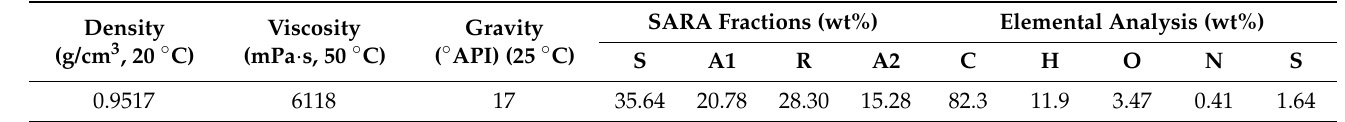
Table 1. Basic properties of the FC extra-heavy oil